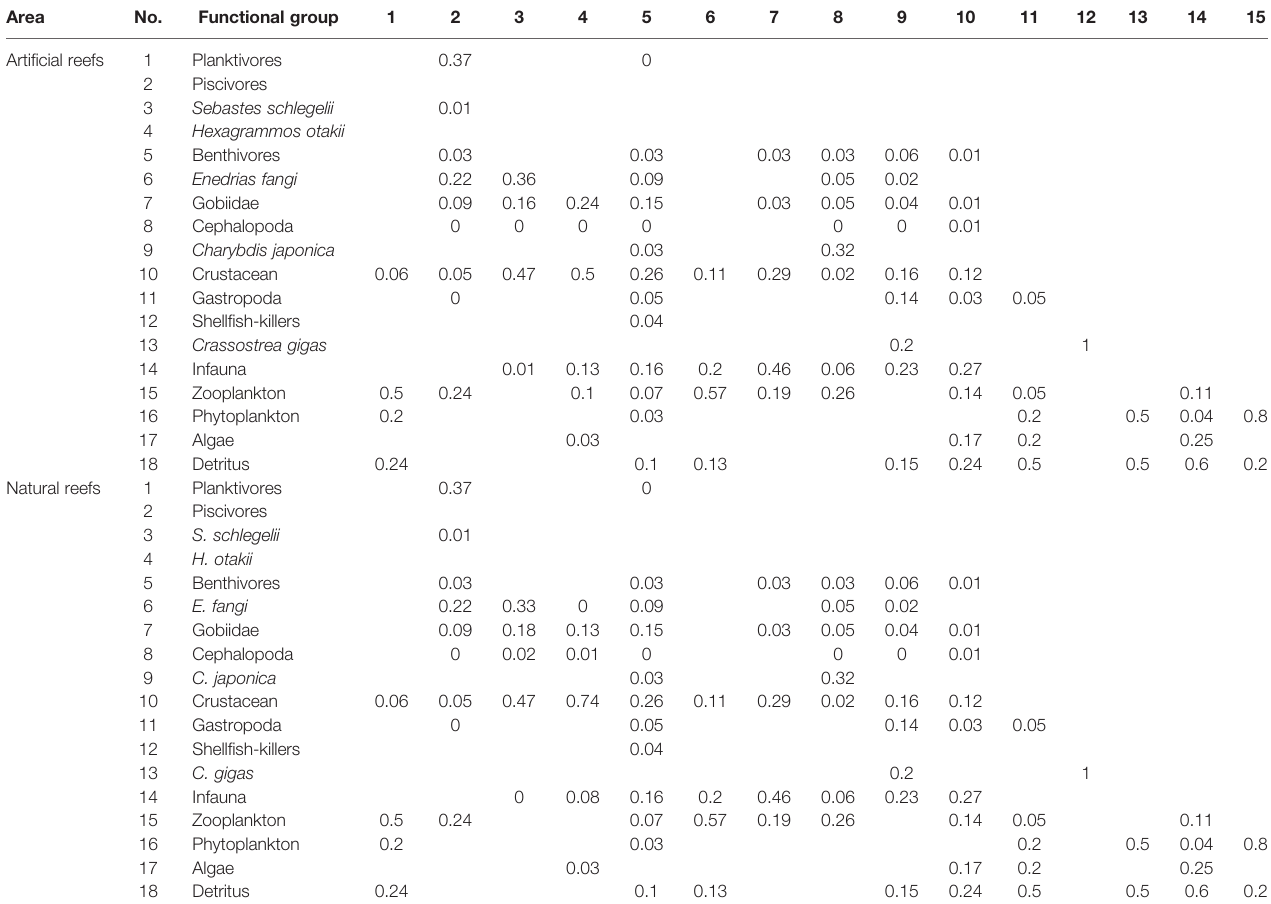
TABLE 3 | Diet matrix imported into the Ecopath models of the arti fi cial and natural reefs on the coast of Yellow Sea, China.